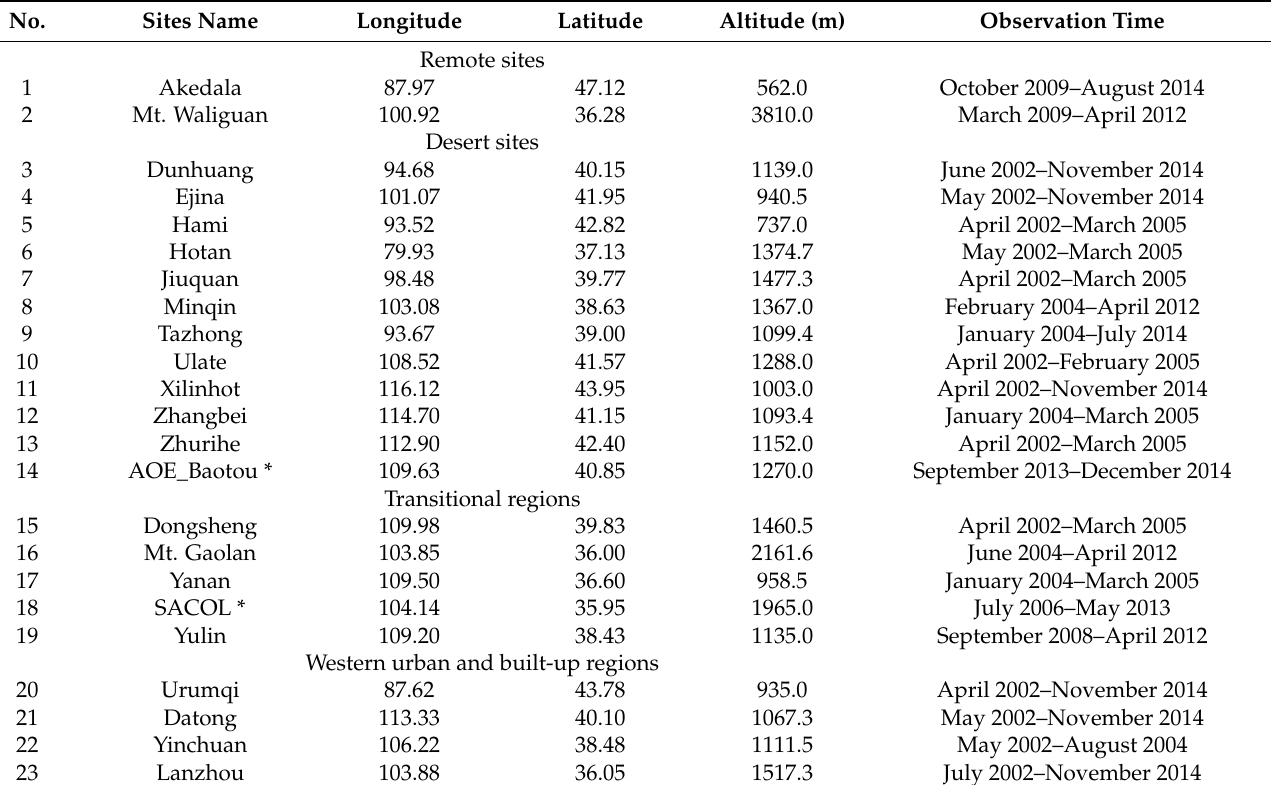
Table 1. Detailed information for CARSNET and AERONET in Northwestern China (Two sites marked with * are AERONET sites, and the remaining 21 are CARSNET